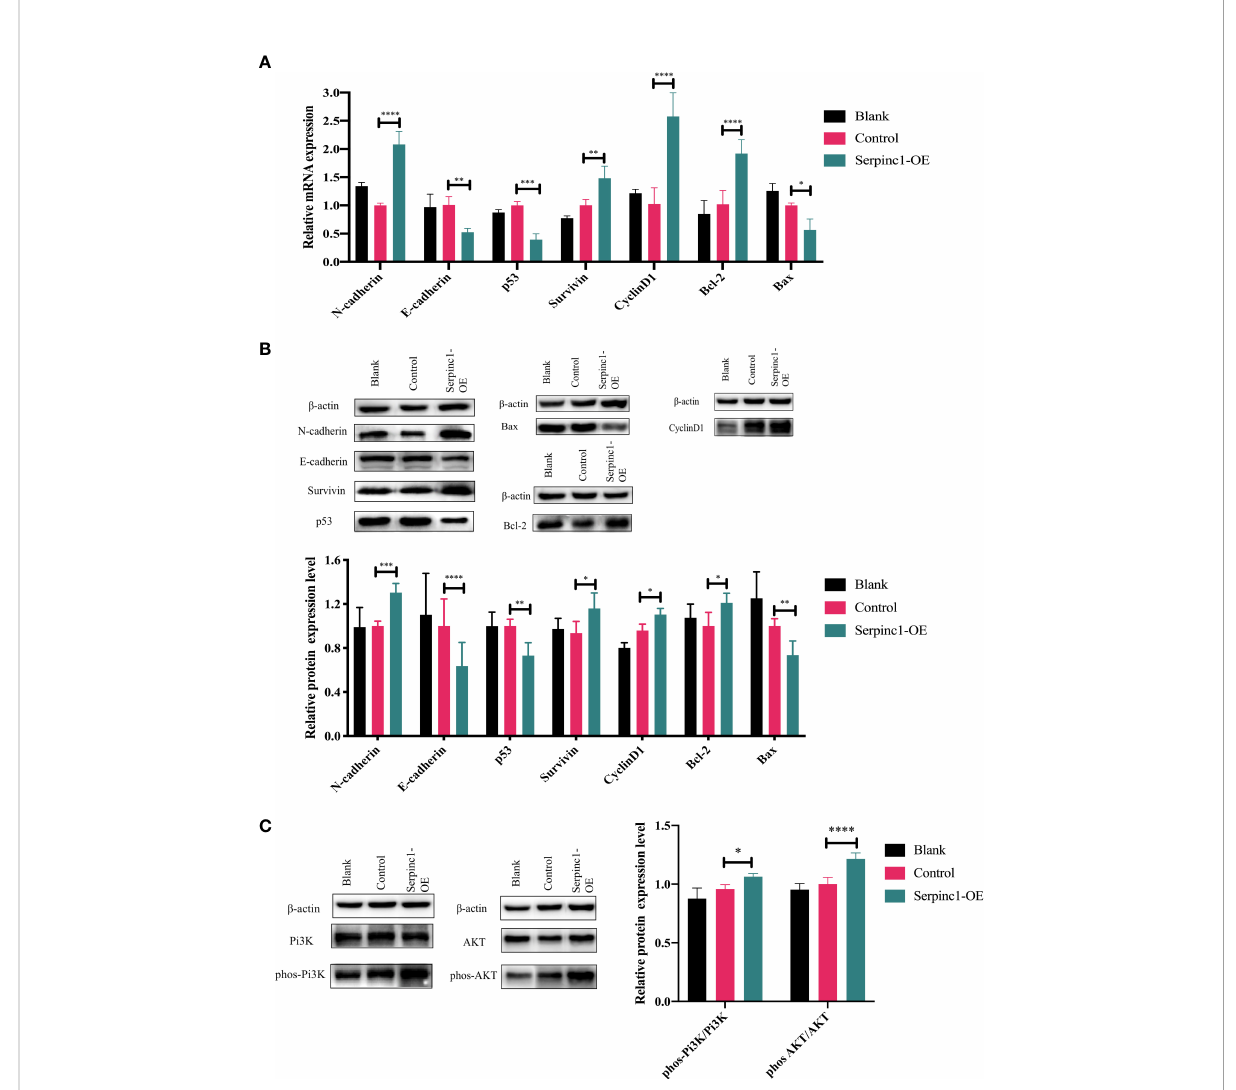
FIGURE 9 Effects of Serpinc1 gene overexpression on the expression of genes and proteins involved in cellular migration, invasion, cycle, and apoptosis. (A) N-cadherin, E-cadherin, p53, Survivin, CyclinD1, Bcl-2, and Bax mRNA in non-transfected blank, empty vector control, and Serpinc1 overexpressing cells ( n = 3). (B) Expression levels of N-cadherin, E-cadherin, p53, Survivin, CyclinD1, Bcl-2, and Bax proteins were determined by Western blotting ( n = 3). (C) The phosphorylation of Pi3K and AKT was determined by Western blot analysis ( n = 3). p -values were analyzed by two-way ANOVA with Tukey ’ s multiple comparisons; comparison between the control vector and Serpinc1 overexpression. * p < 0.05, ** p < 0.01, *** p < 0.001, **** p < 0.0001. Bcl-2, B-cell lymphoma 2; Bax, Bcl-2-associated X protein; AKT, protein kinase B; Pi3K, phosphatidylinositol